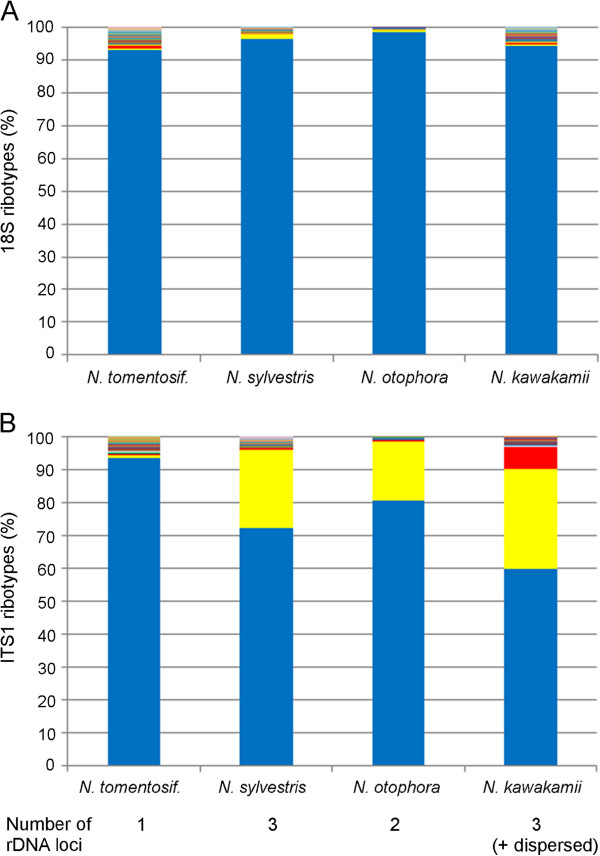
Relative abundance of individual clusters in 454 generated (A) 18S rDNA and (B) ITS1 sequences. The clusters are distinguished by SNPs, with clusters carrying indels having been merged with clusters that carry the same SNP profile.